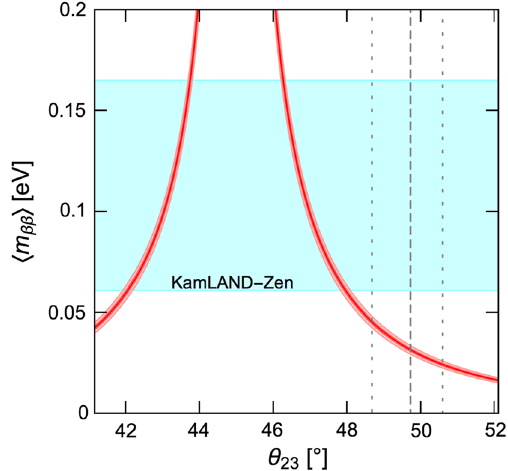
Fig. 5 The predictions for the effective Majorana neutrino mass in the C R case. The red line shows the prediction as functions of θ 23 and the dark (light) red bands show the uncertainty coming from the 1 σ (3 σ ) errors of the other parameters. The vertical gray lines are the same as Fig. 2. The light blue band shows the current bound on (cid:2) m ββ (cid:3) given by the KamLAND- Zen experiment, (cid:2) m ββ (cid:3) < 0 . 061 − 0 . 165 eV